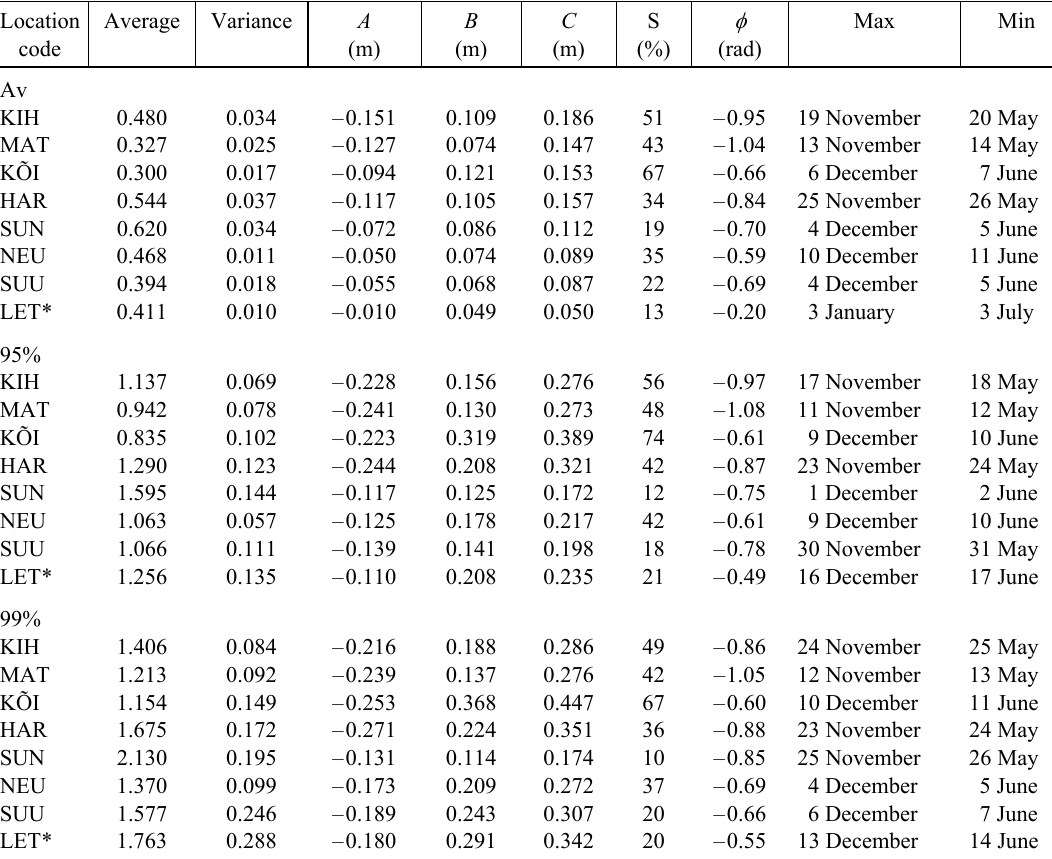
Table 2. Statistics of 11 year H s time series and parameters of sinusoidal seasonal harmonics ( A , B , C ) found from Fourier analysis for monthly averages (Av), 95th and 99th percentiles. 2 C would be the range for seasonal variations. The calculation of dates for annual maxima and minima was based on the phase (  ), considering 15 January as the initial point of the series and the average length of month 30.3 days. S – share of the seasonal component out of 66 Fourier coefficients (with total variance 100%). * Calculation based on 10 years and 60 harmonics. Location